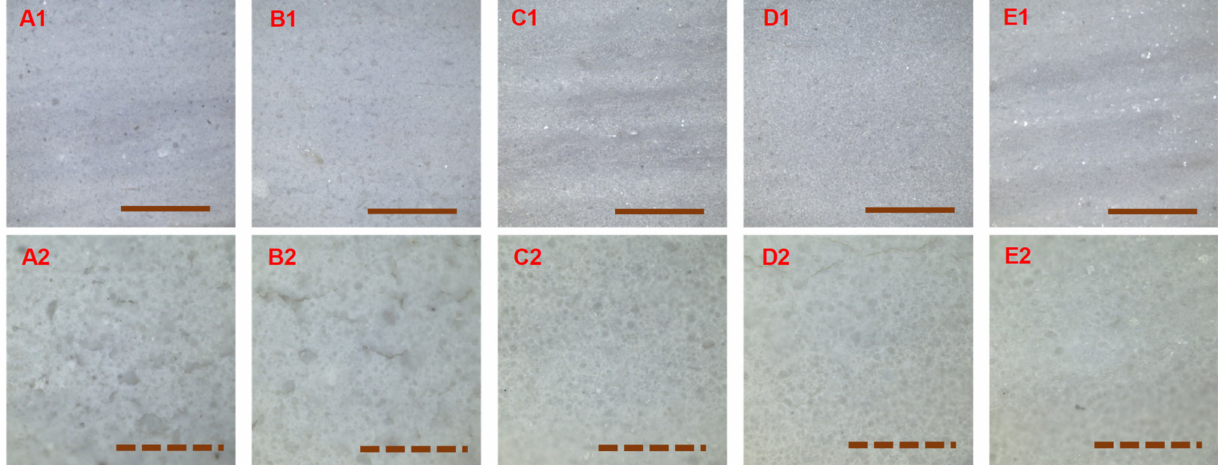
Figure 4. 2D micrographs of the surface of the cured coatings at magnifications 5 × ( A1 – E1 ) and 20 × ( A2 – E2 ): SW1 ( A ), SW2 ( B ), SW3 ( C ), SW4 ( D ), and SW5 ( E ) (the solid line scale bars represent 1 mm and the dash line scale bars 300 µ